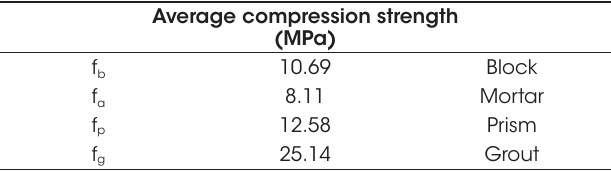
Materials characterization